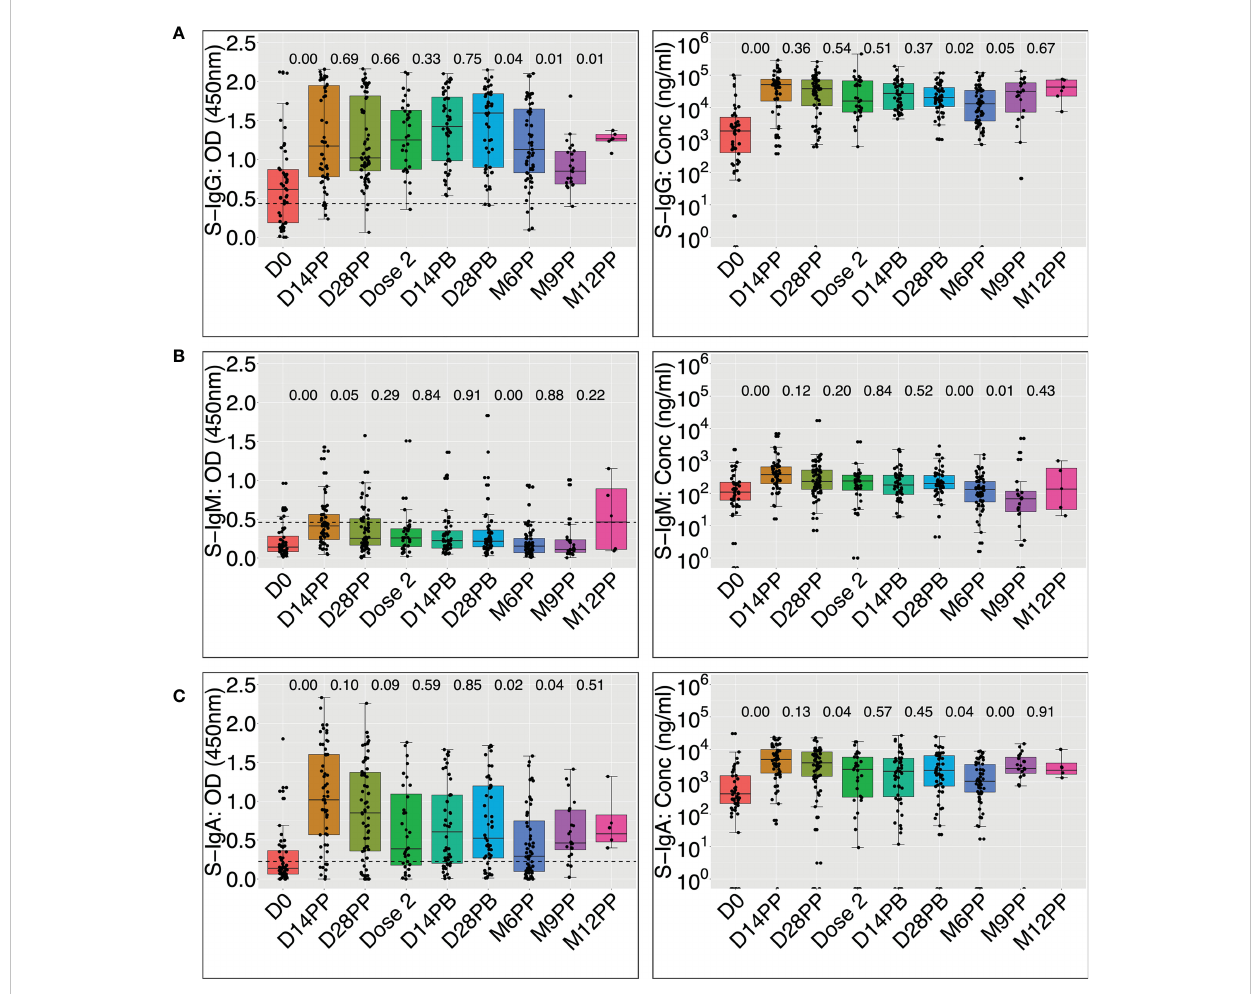
FIGURE 4 Box plots comparing vaccine-induced median spike-directed IgG, IgM and IgA antibody levels over time Figure 4 uses the Wilcoxon signed rank test to compare median OD values at 450 nm and concentrations (ng/ml) of the spike-directed IgG, IgM, and IgA antibody levels across time points. OD at 450nm and concentrations are shown for IgG (A) , IgM (B) , and IgA (C) . P-values for differences between OD values or concentrations across adjacent time points are indicated. Horizontal dashed lines indicate cut-offs for the respective antibody isotypes. P values of 0.05 or less are considered statistically signi fi cant. The cut-offs for spike-directed IgG, IgM and IgA seropositivity were 0.432, 0.459 and 0.226,